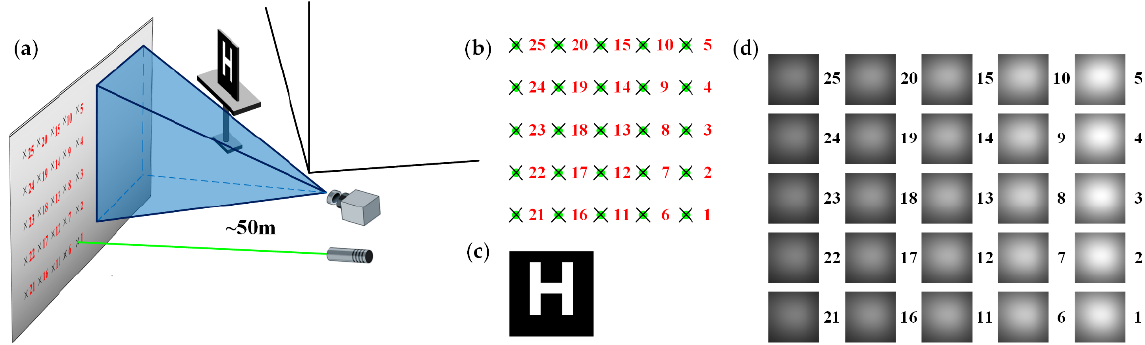
Figure 3. ( a ) NLOS scene; ( b ) laser scanning sequence; ( c ) hidden target example; ( d ) projected images corresponding to laser scanning positions.